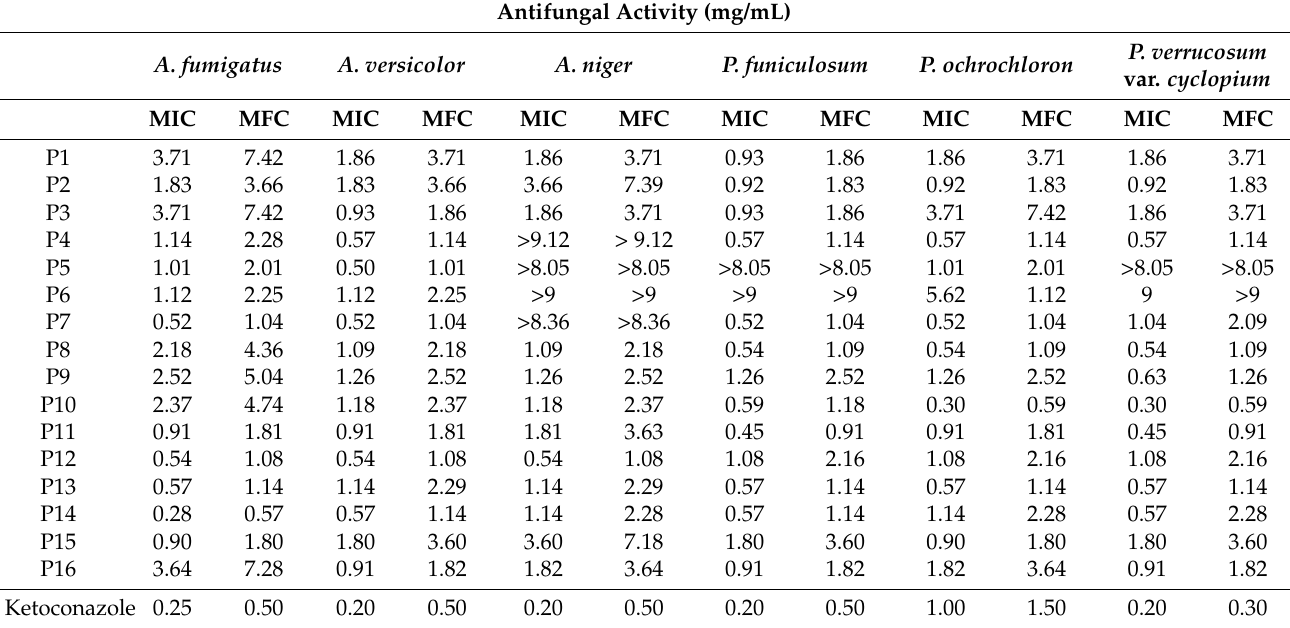
Table 7. Antifungal activity of the hydroethanolic extracts of cardoon